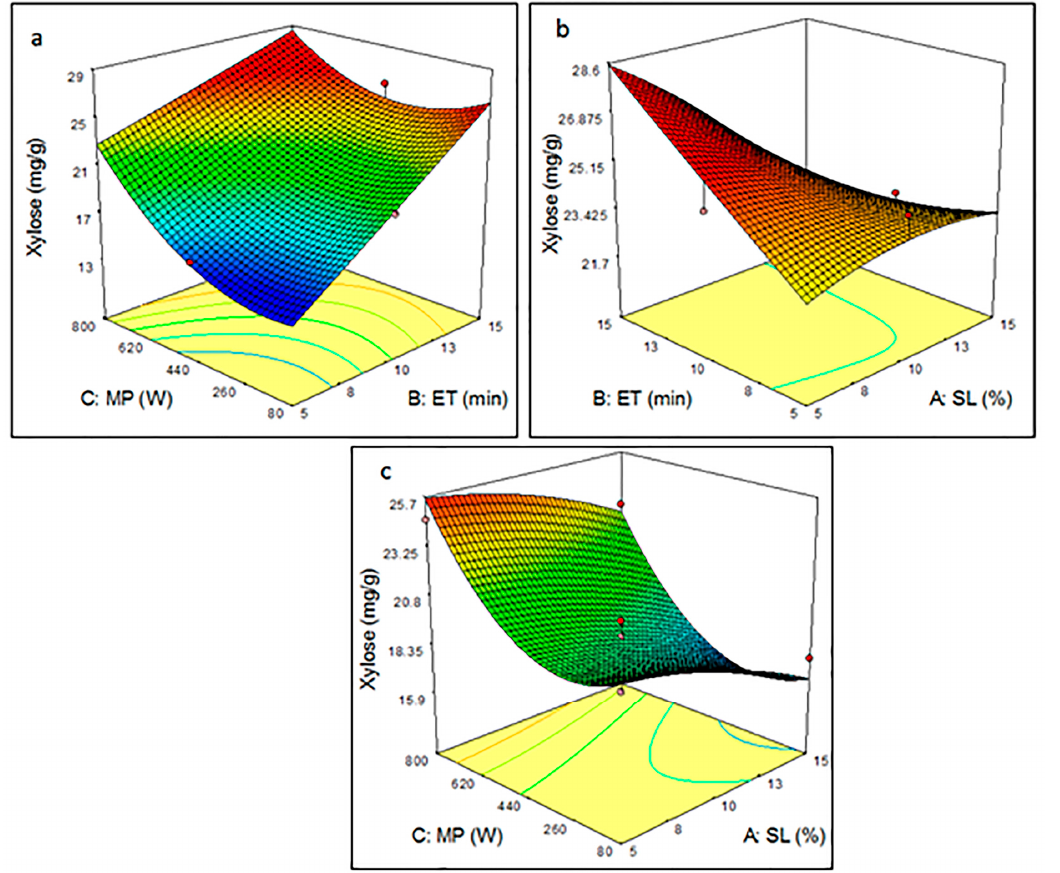
Figure 6. The effect of pretreatment parameters of MSH pretreatment on the xylose yield ( a ) with MP and ET at a constant SL, ( b ) with ET and SL at a constant MP, and ( c ) with MP and SL at a constant ET.